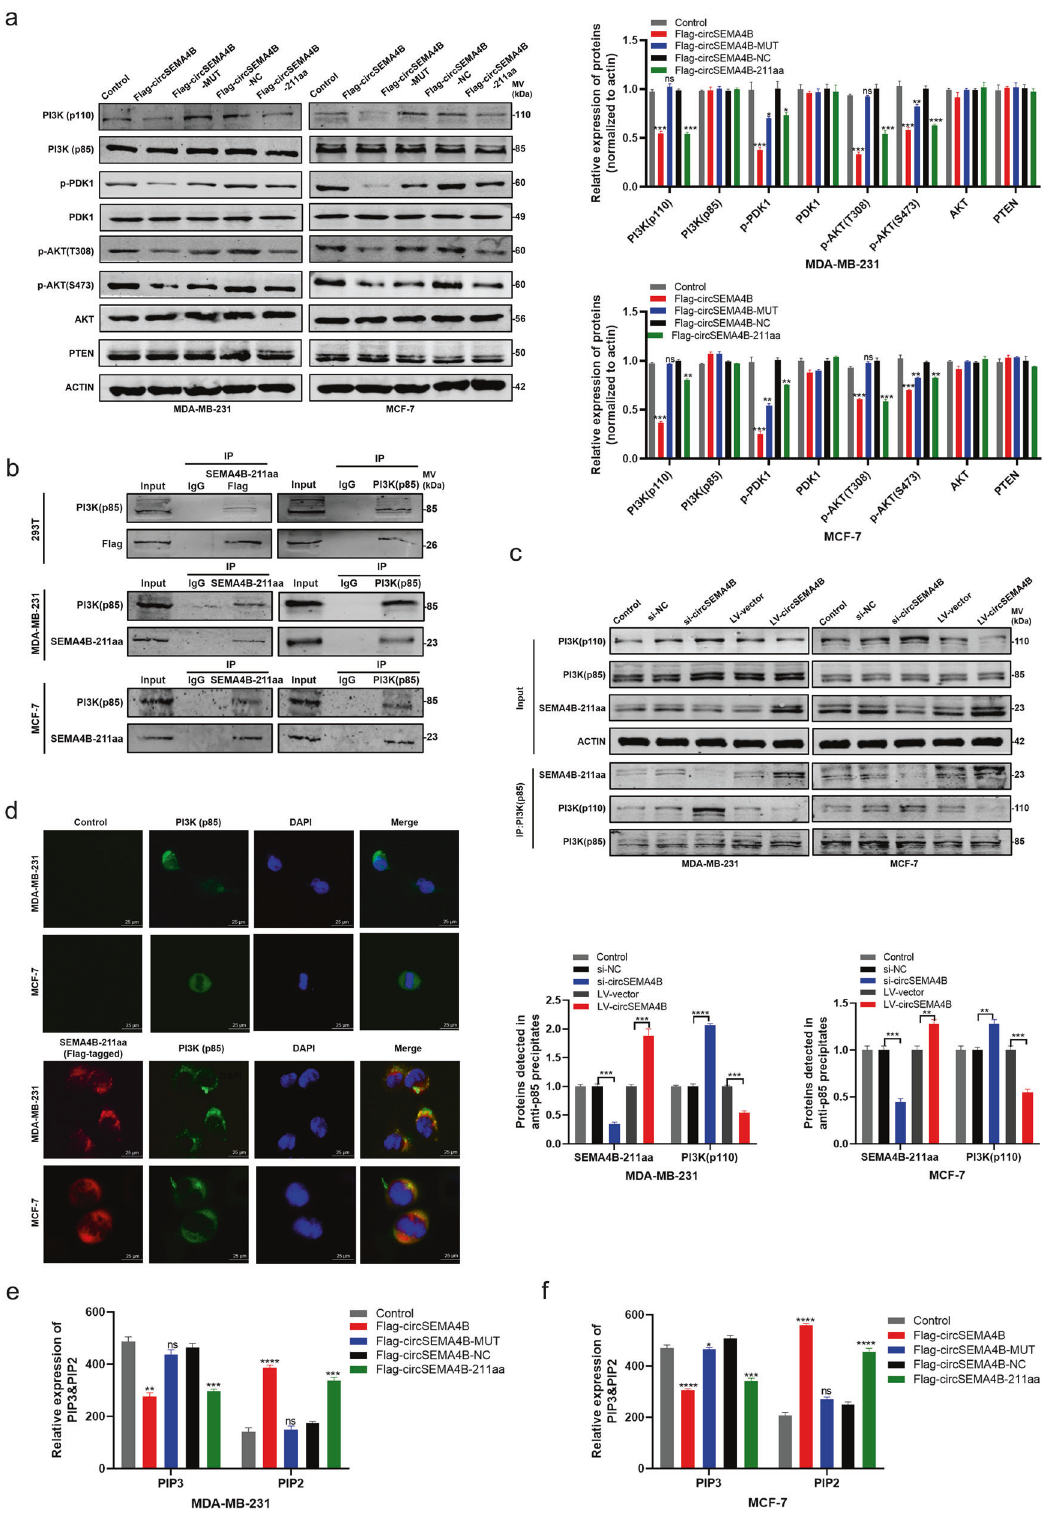
Fig. 5 SEMA4B-211aa interacts with p85 and regulates PI3K activity. a Expression of key proteins in PI3K pathway were detected in BC cells transfected with Flag-circSEMA4B, Flag-circSEMA4B-MUT, Flag-circSEMA4B-NC, and Flag-circSEMA4B-211aa. b Mutual interaction of p85 and SEMA4B-211aa were determined by Co-IP. c p85/p110 complex was in fl uenced by SEMA4B-211aa by Co-IP. d Colocalization of p85 and SEMA4B-211aa in BC cells. Red, SEMA4B-211aa; green, p85; blue, DAPI. e , f PI3K activity was determined by ELISA according to PIP2/PIP3 expression in BC cells transfected with Flag-circSEMA4B, Flag-circSEMA4B-MUT, Flag-circSEMA4B-NC, and Flag-circSEMA4B-211aa.